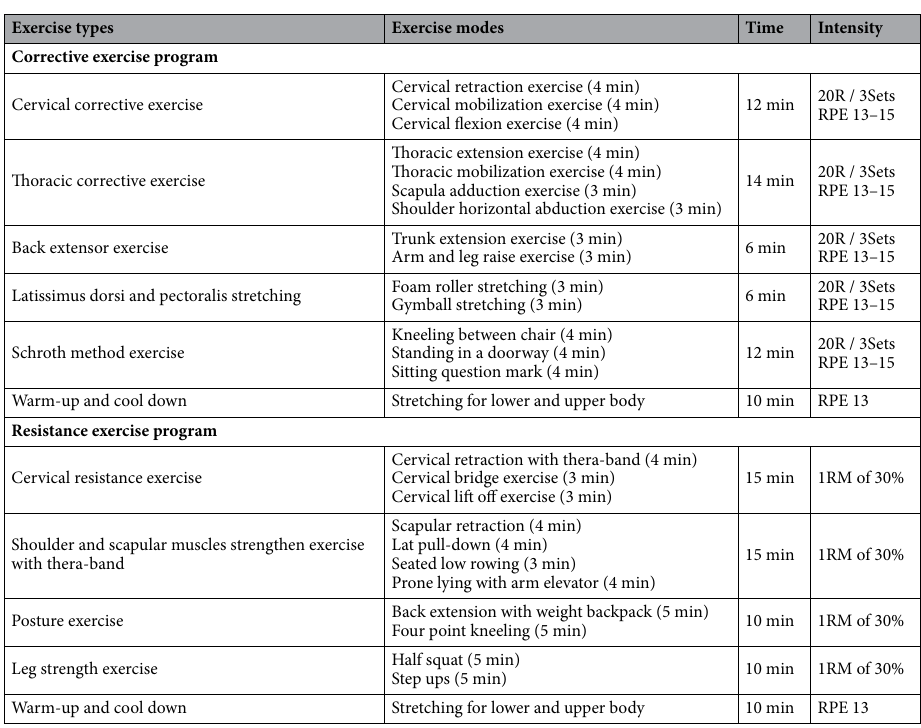
Table 3. The exercise program was divided into two active intervention groups including corrective and resistance exercise. RM repetition maximum, RPE rating of perceived